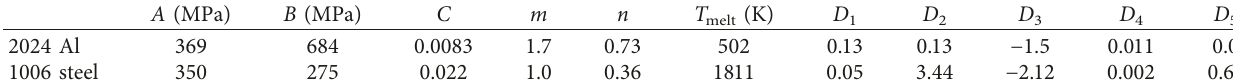
Table 2: Johnson–Cook material constants for the airplane.